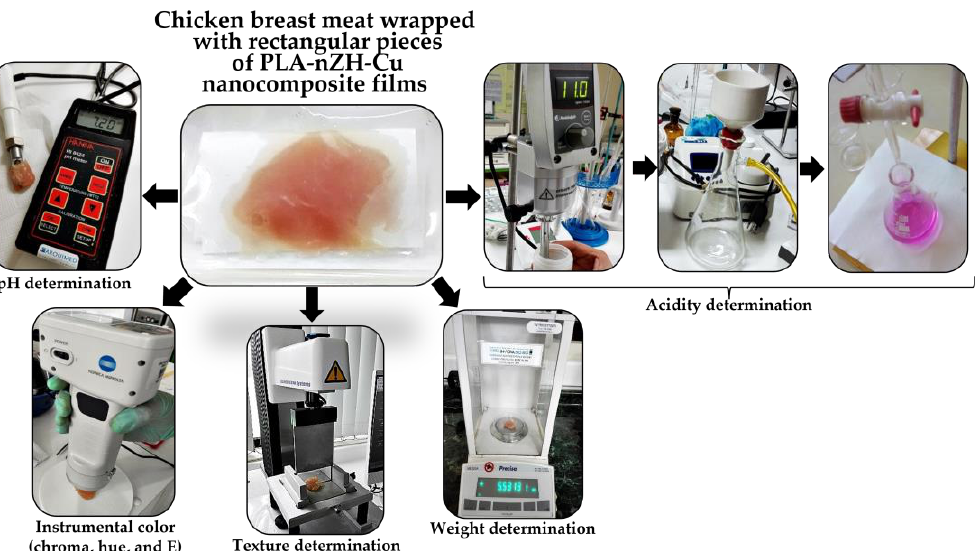
Figure 5. Evaluation of the PLA-nZH-Cu nanocomposite film’s role in the organoleptic and physicochemical qualities of the chicken breast. Each test was carried out consecutively for 0, 10, and 20 days of storage.